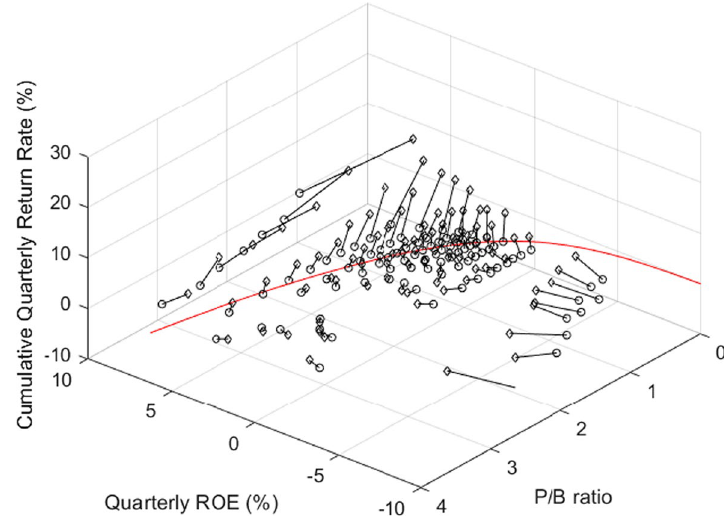
Fig. 29 The relationships among ROE, P/B, and cumulative quarterly return rates (circle: the data in the t Quarter, diamond: the data in the t 1 +